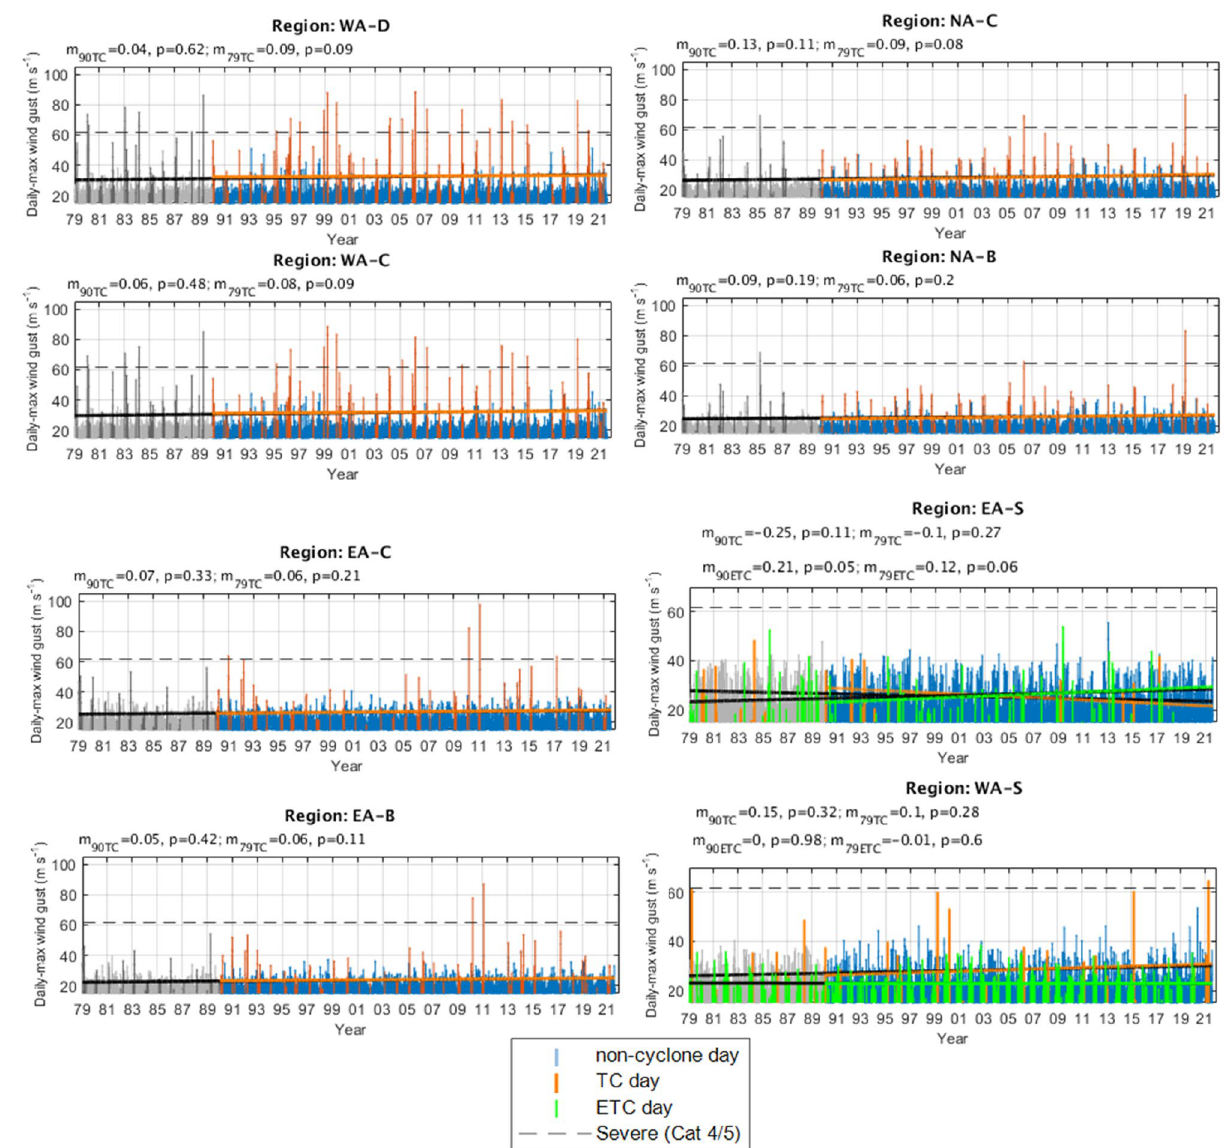
Figure 4. As in Fig. 3 but for the calibrated ERA5 reanalysis. As this data extends back to 1979, an additional trend line is fitted (black lines). Daily maximum wind gusts occurring before 1990 have been greyed